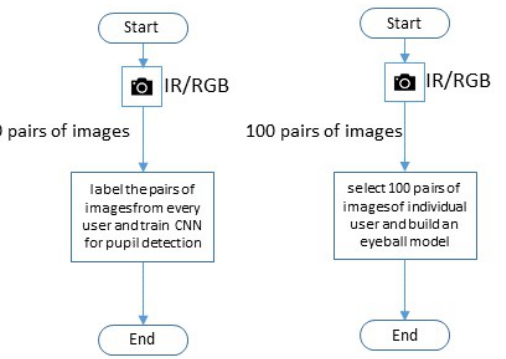
Figure 7. The flowchart for the model describing the procedure of choosing test